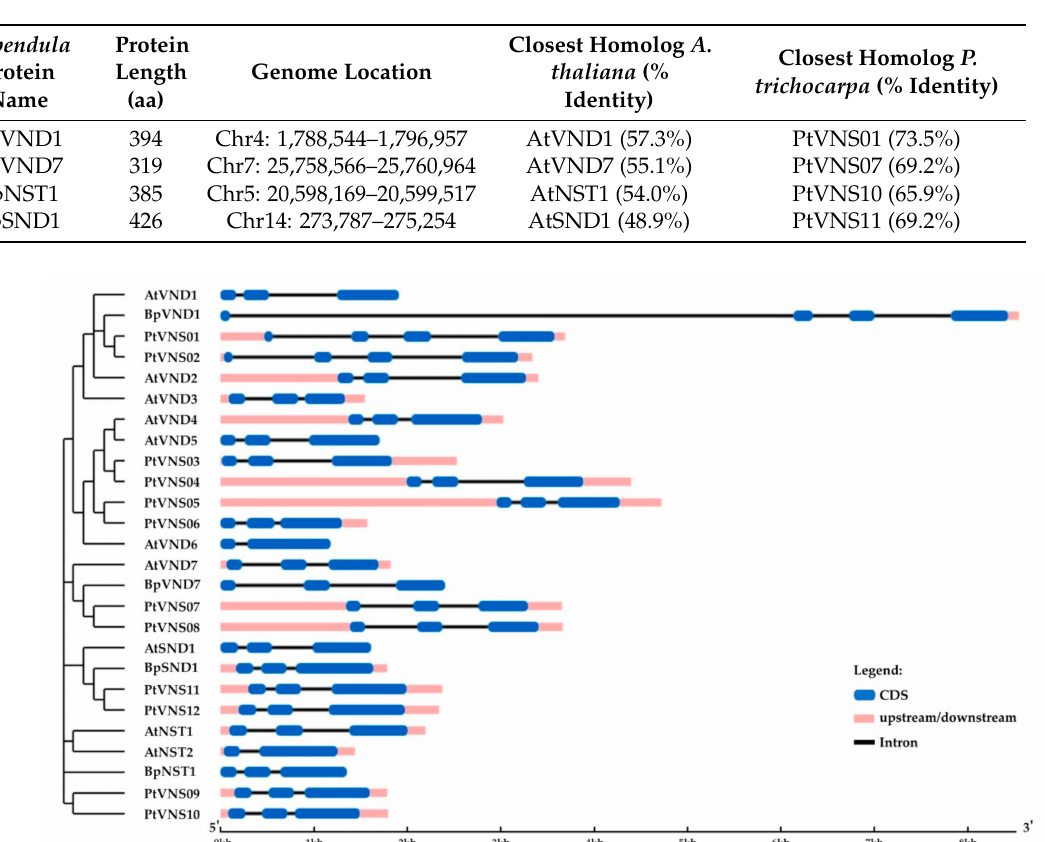
Table 1. Characteristics of VND and NST members in birch.